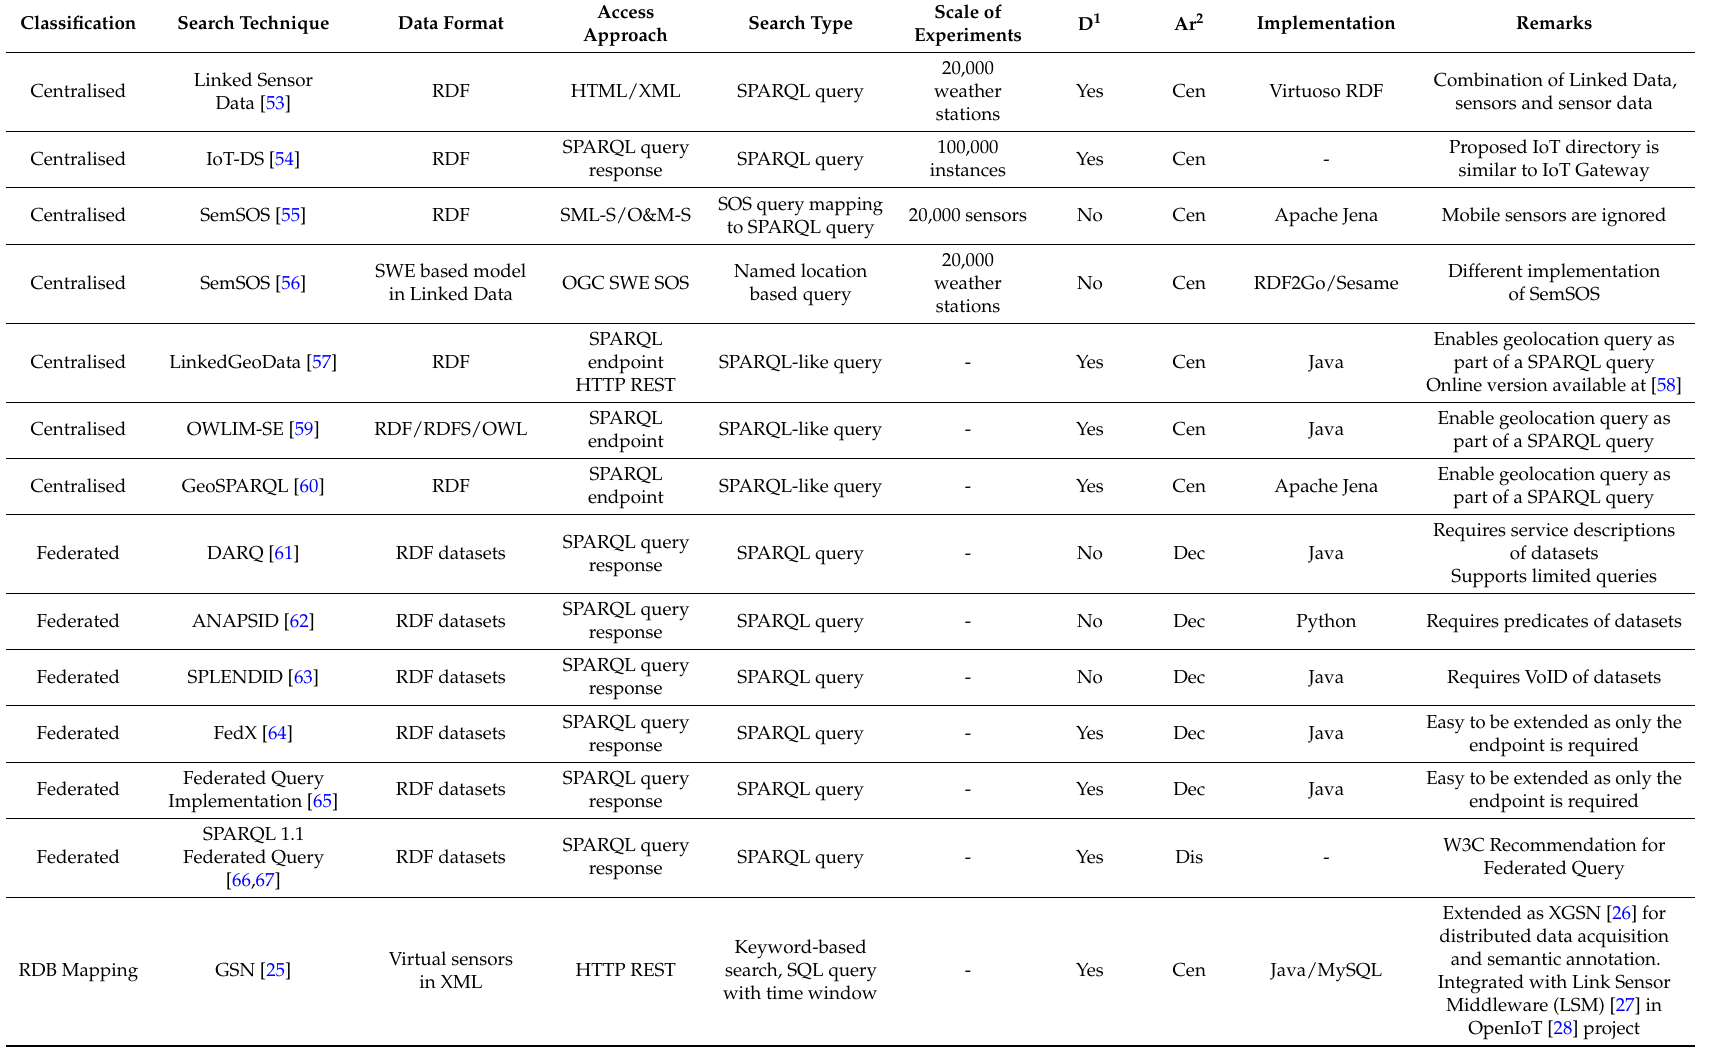
Table 3. Comparison of Search Techniques According to Data/Knowledge Representation (Abbreviations are listed in the footer of Table 2).